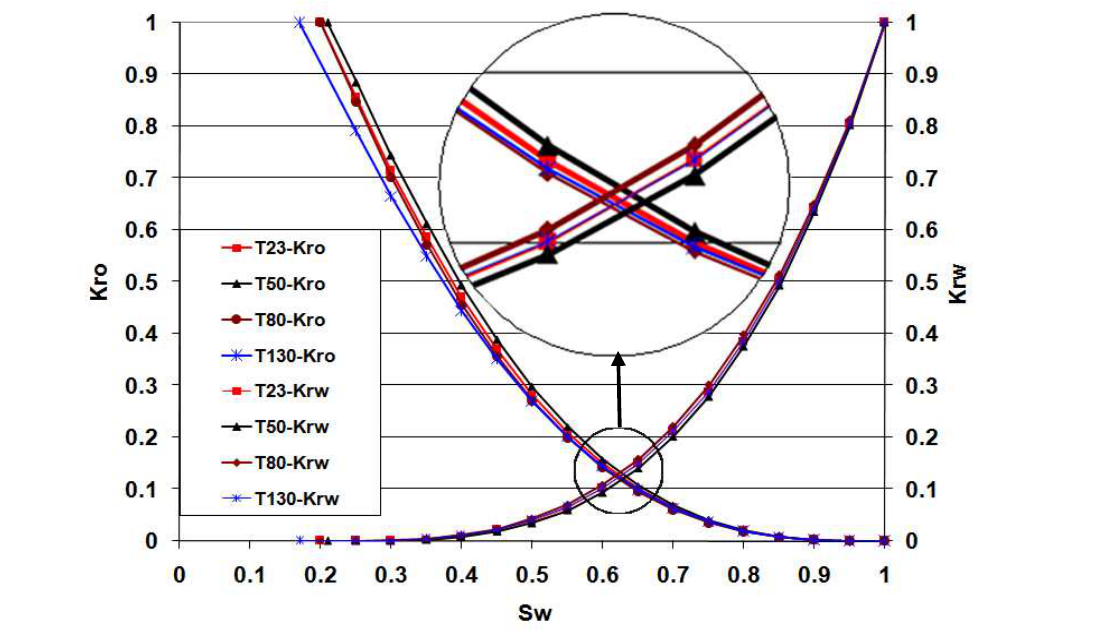
Figure 4. Calculated relative permeability data using equation 3 and 4. S are taken from experimental relative permeability